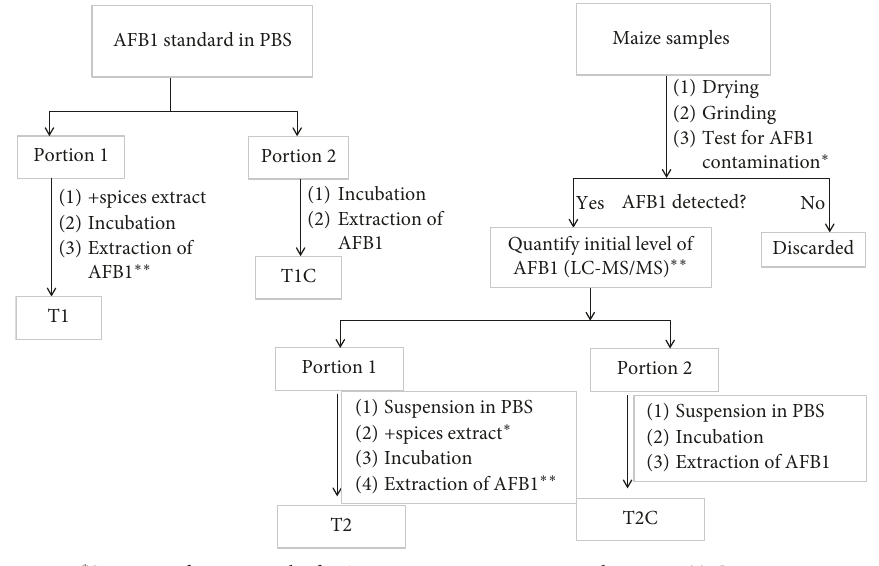
Figure 1: A schematic of the overall procedure followed for the determination of efficacy of the spices against aflatoxin